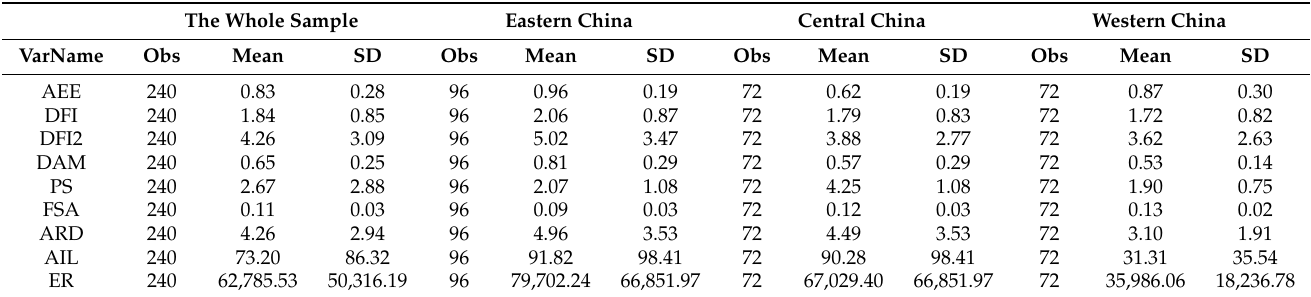
Table 2. Descriptive statistics of variables of the whole sample and